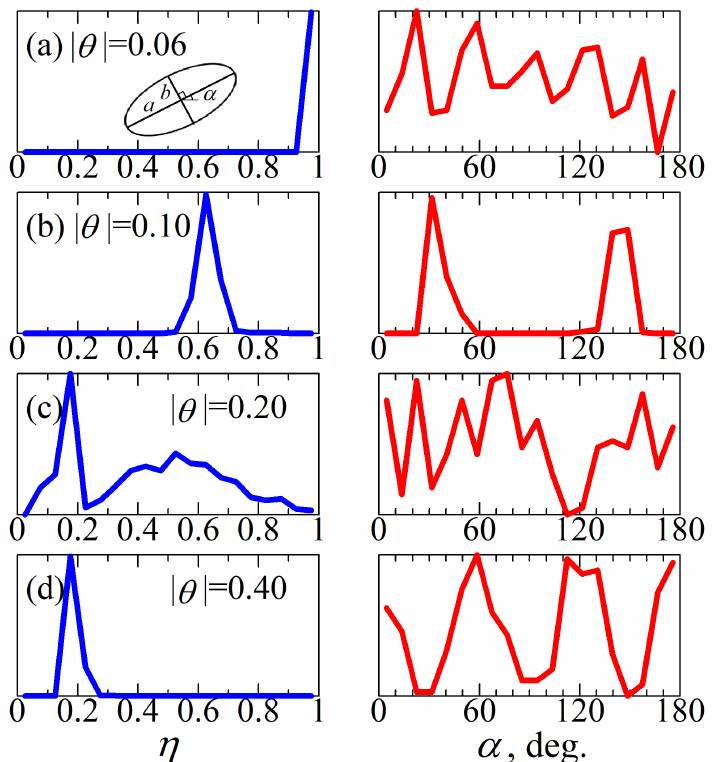
Figure 3. 20 bin histograms showing the distribution of CNT cross section ellipticity η = b / a (at left) and orientation angle α (at right). Parameters a , b and α are defined in the inset in (a), left